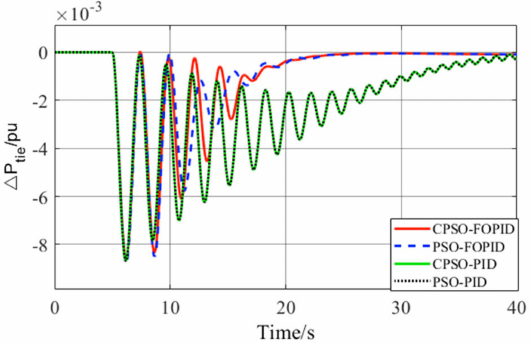
Figure 5. Power variation curve of system tie line under a step disturbance.